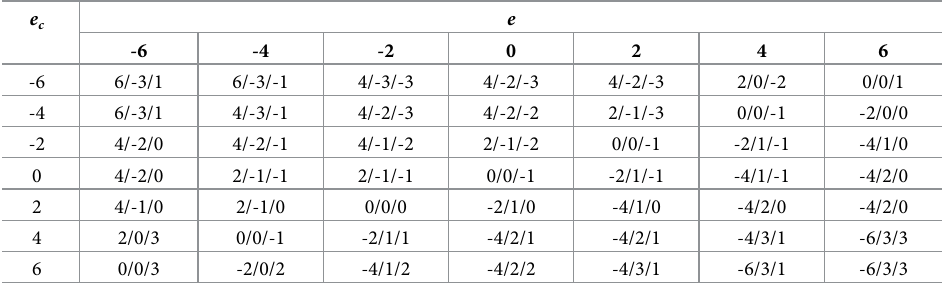
Table 2. Fuzzy control rules table of Δ K P Δ K I and Δ K D for deviation